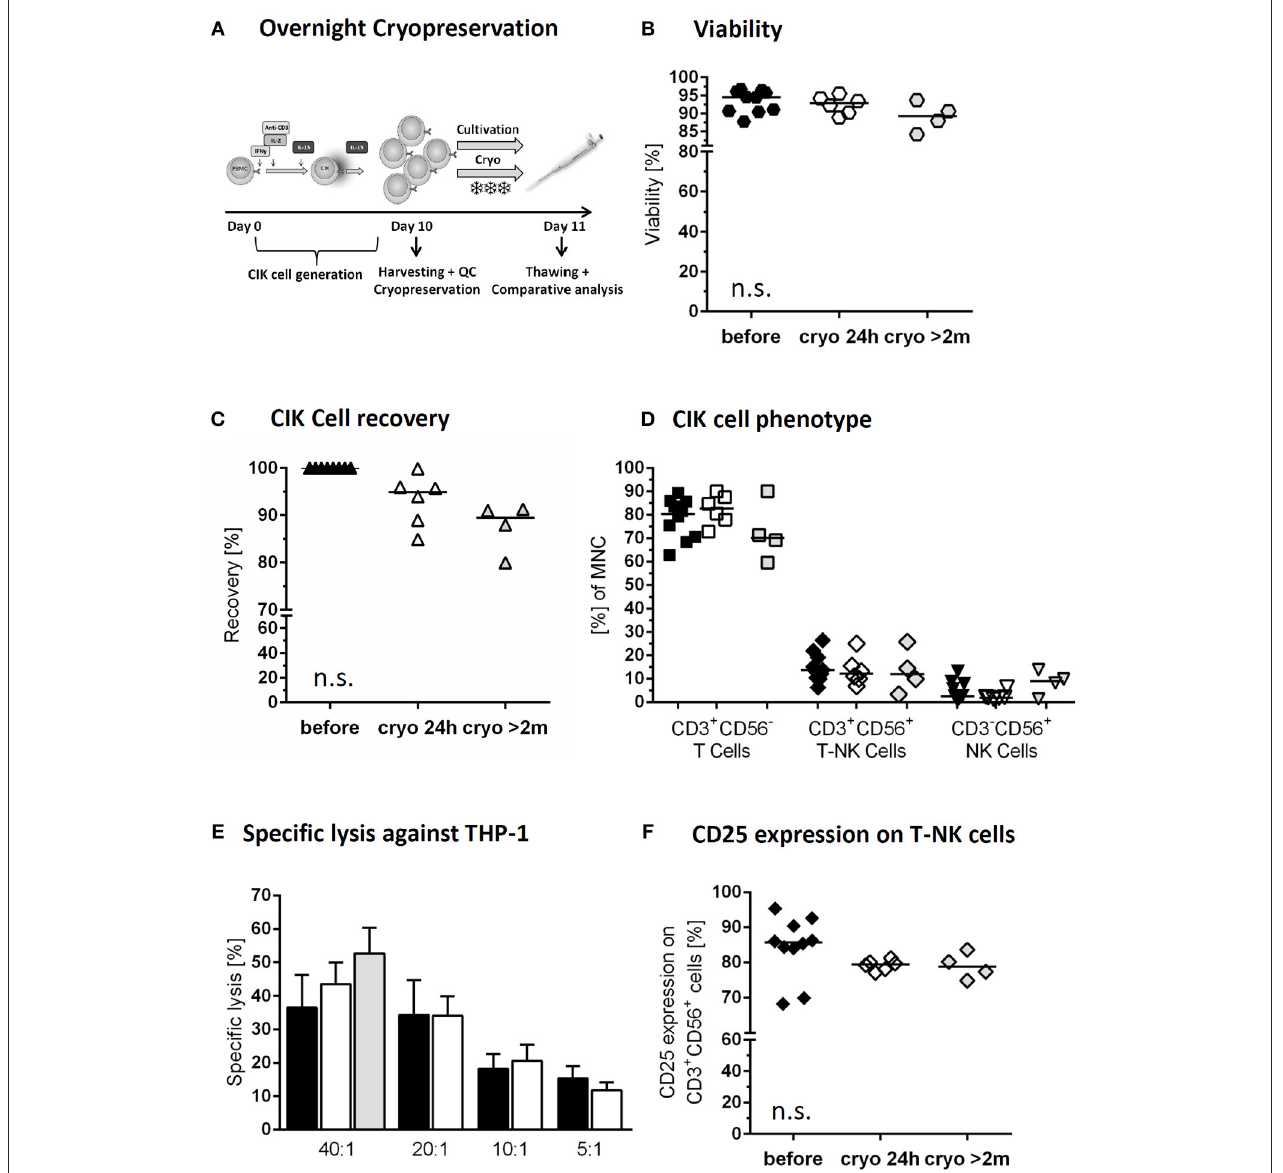
FIGURE 3 | Cryopreservation of CIK cells. Comparison of freshly harvested CIK cells (black) and CIK cells following overnight cryopreservation of the same donor (white). In addition long time storage of at least 2months (median 2 years) was investigated (gray; differing donors) (A) On day 10, one part of the freshly harvested CIK cells was cryopreserved overnight, whereas a second part was further cultivated overnight. (B) Viability was slightly, but not significantly, reduced due to overnight and long-term cryopreservation. (C) CIK cell recovery was 94.9% after thawing following overnight cryopreservation an 89.5% after long-term storage. (D) The composition of CIK cells consisting of T-, T-NK- and NK-cells was not significantly influenced by overnight and long-term cryopreservation. (E) Cytotoxicity against THP-1 of CIK cells before and after cryopreservation was comparable in the tested effector/target ratios 40:1, 20:1, 10:1, and 5:1 for overnight ( n = 6) and long-term cryopreservation ( n = 3). (F) Independent of storage time CD25 expression on CD3 + CD56 + cells minimally decreased following cryopreservation, but not statistically relevant. n = 6 experiments.